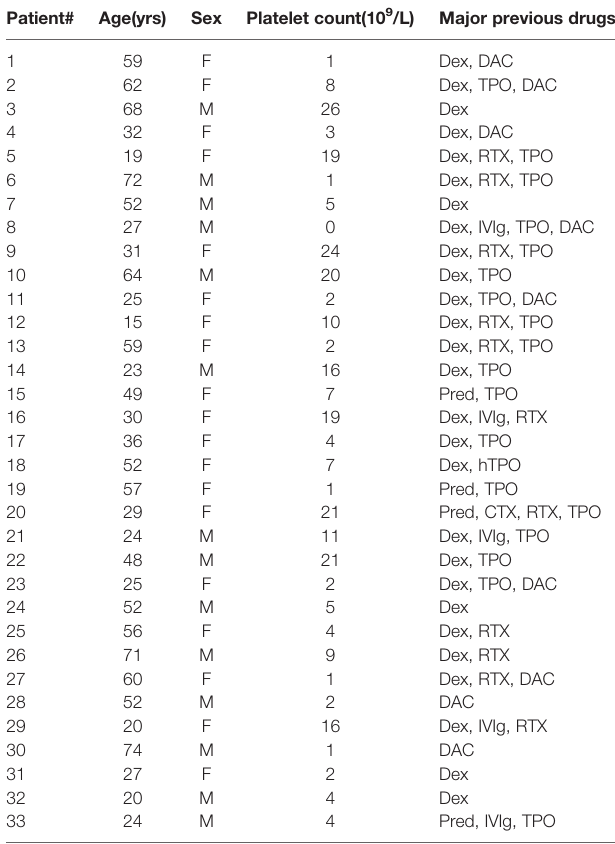
TABLE 1 | ITP patient characteristics. Patient# Age(yrs) Sex Platelet count(10 9 /L) Major previous